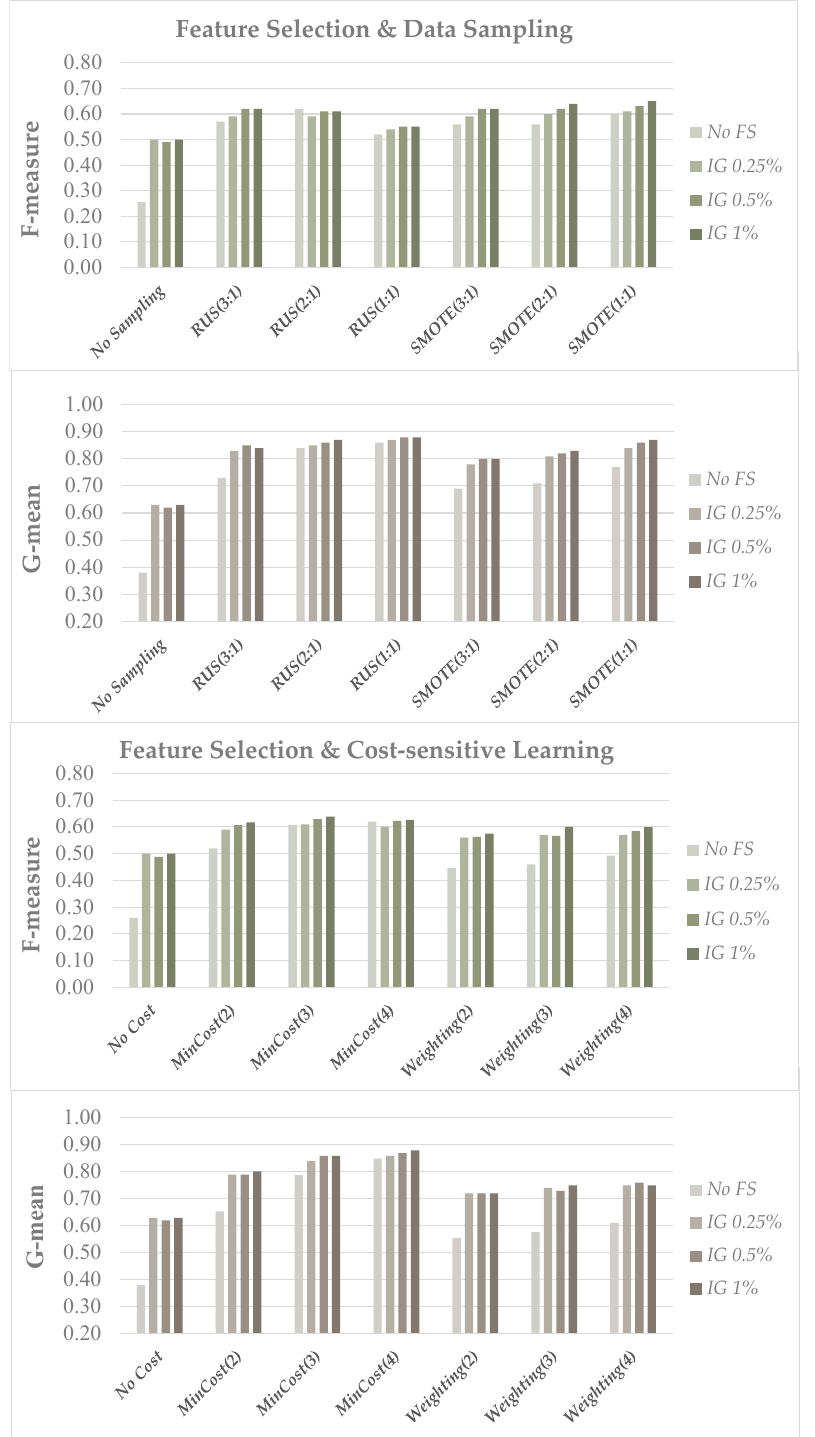
Figure 2. Uterus dataset: F-measure and G-mean performance of the RF classifier in conjunction with feature selection (IG ranker) and imbalance learning methods (data sampling and cost-sensitive learning), for different percentages of selected features (0.25, 0.5 and 1% of the original data dimensionality).